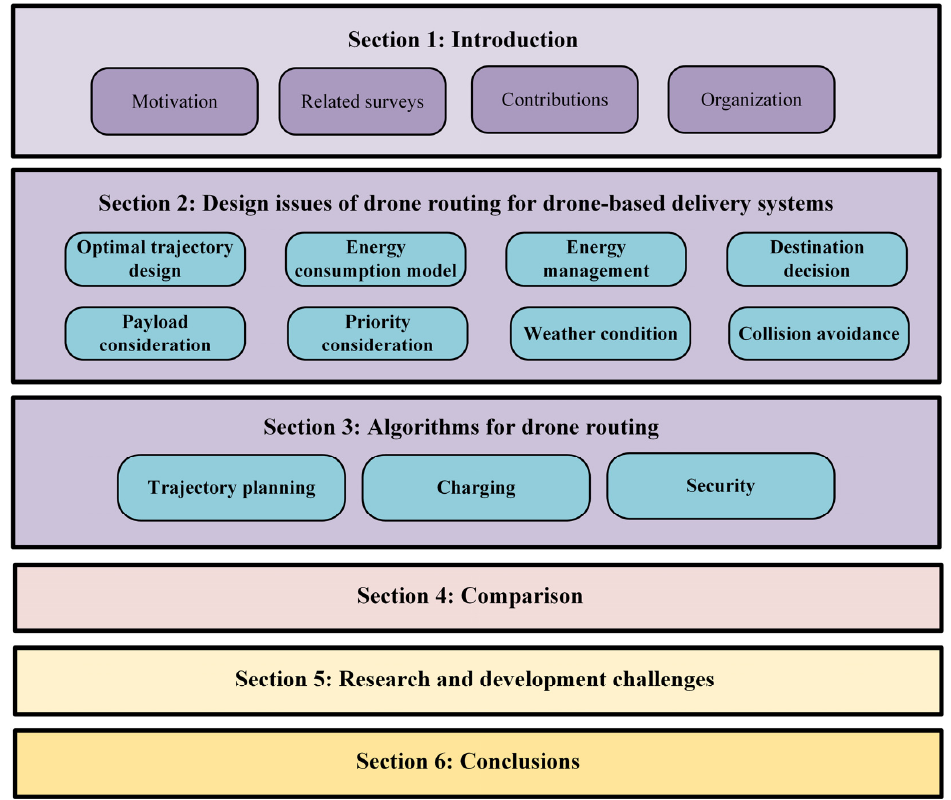
Figure 2. Outline of the survey.